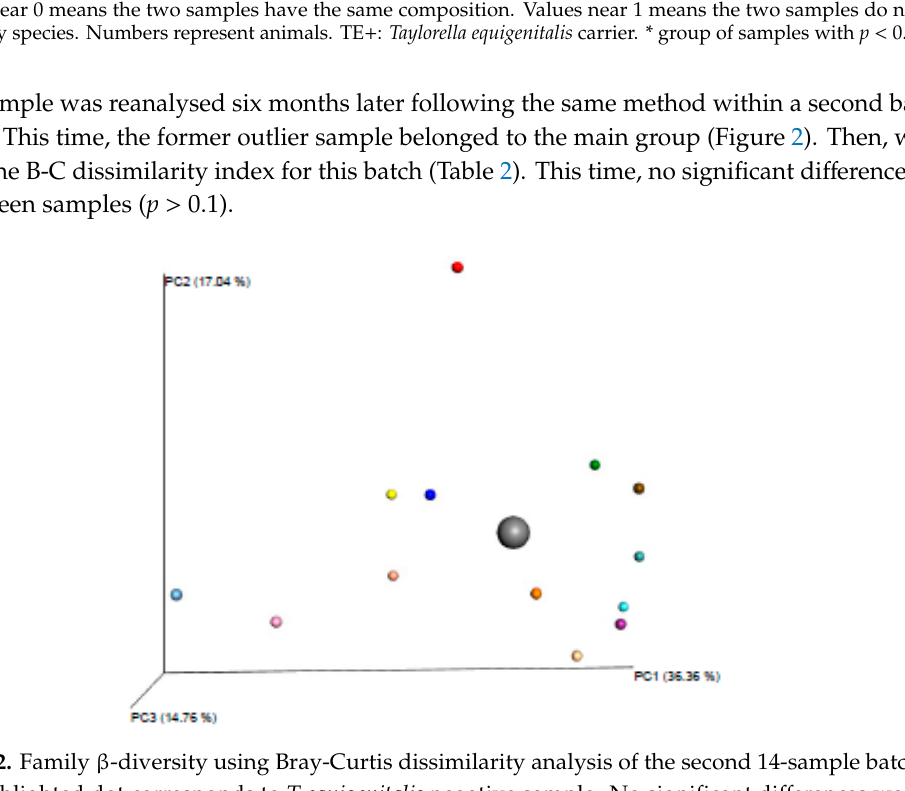
Figure 2. Family β -diversity using Bray-Curtis dissimilarity analysis of the second 14-sample batch. The highlighted dot corresponds to T equigenitalis negative sample. No significant differences were found between the Taylorella equigenitalis negative sample composition and the rest of samples ( p > 0.1).